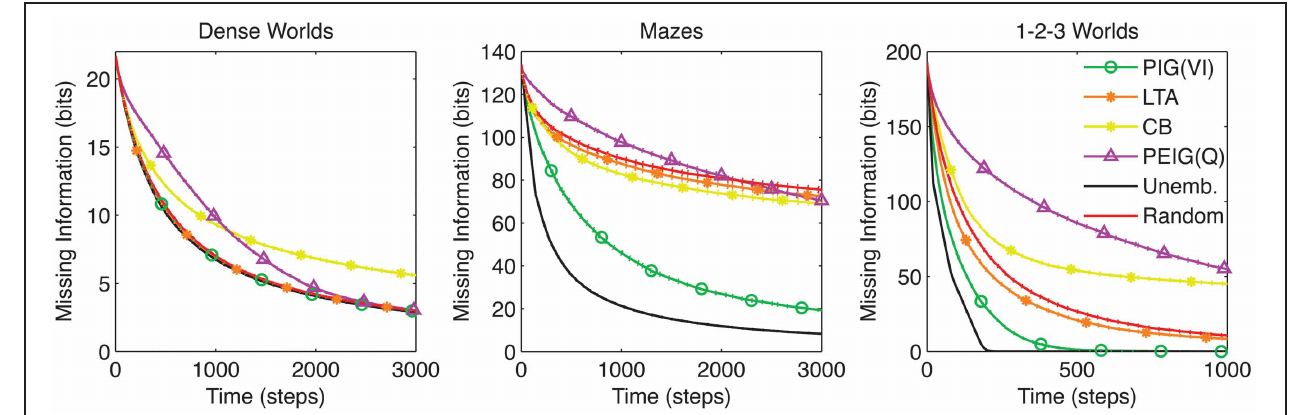
FIGURE 6 | Comparison to previous exploration strategies. The average missing information is plotted over time for PIG(VI) agents along with three exploration strategies from the literature: least taken action (LTA) (Sato et al., 1988; Barto and Singh, 1990; Si et al., 2007), counter-based (CB)